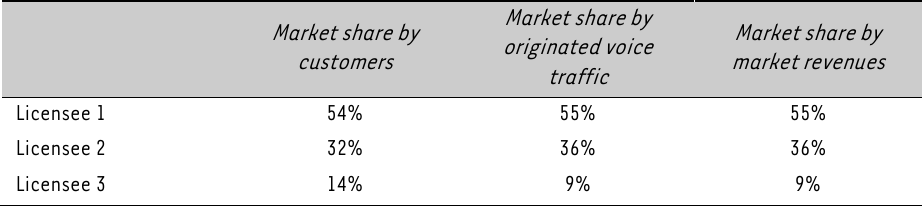
Retail mobile market shares, by total customer connections, originated voice minutes, and revenues, as at June 2009 Market share by Market share by Market share by originated voice customers market revenues traffic Licensee 1 54% 55%